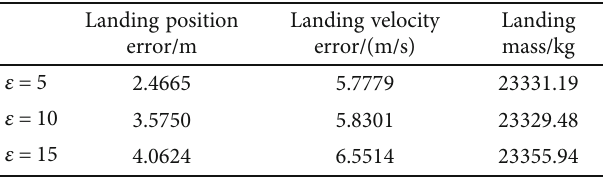
Table 4: Landing errors and masses under the condition that the navigation system has faults.